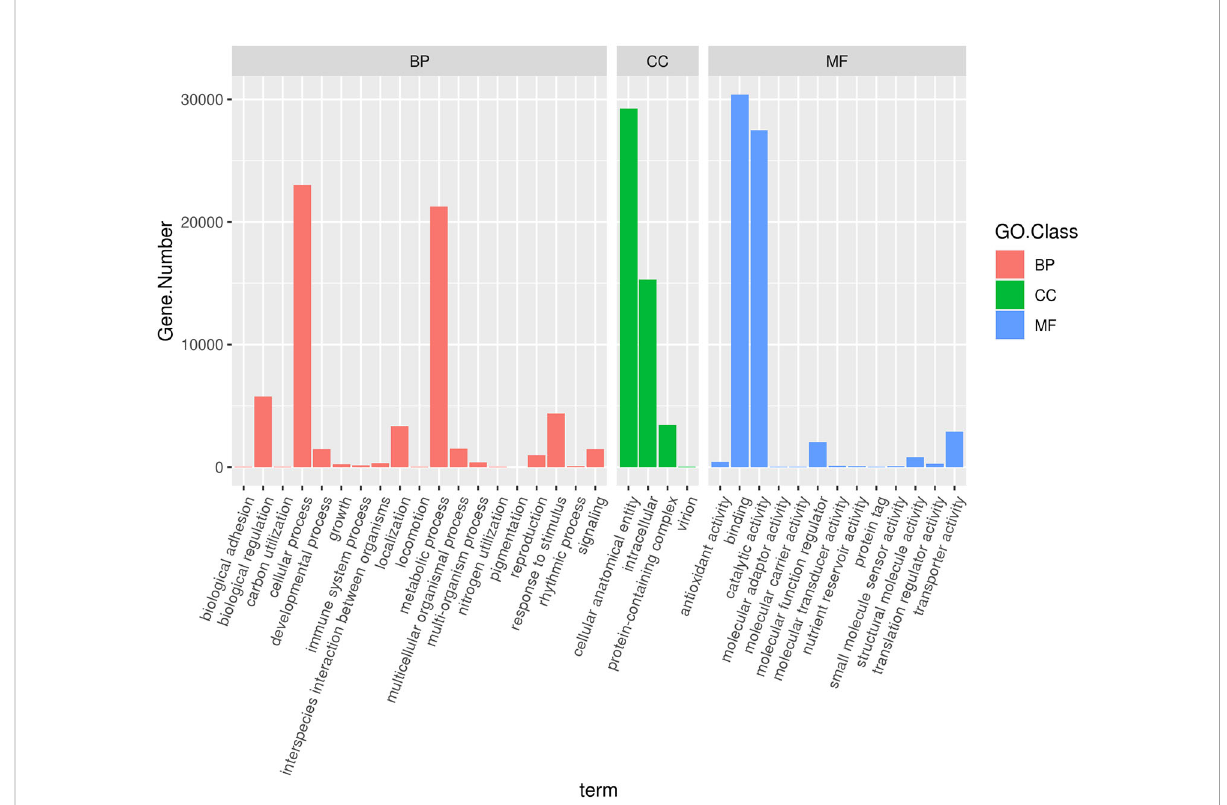
FIGURE 4 Gene ontology (GO) annotation of fi nger millet unigenes to biological process (BP), cellular component (CC), and Molecular function (MF) functional categories. X-axis indicates GO terms and Y-axis indicates number of unigenes at each